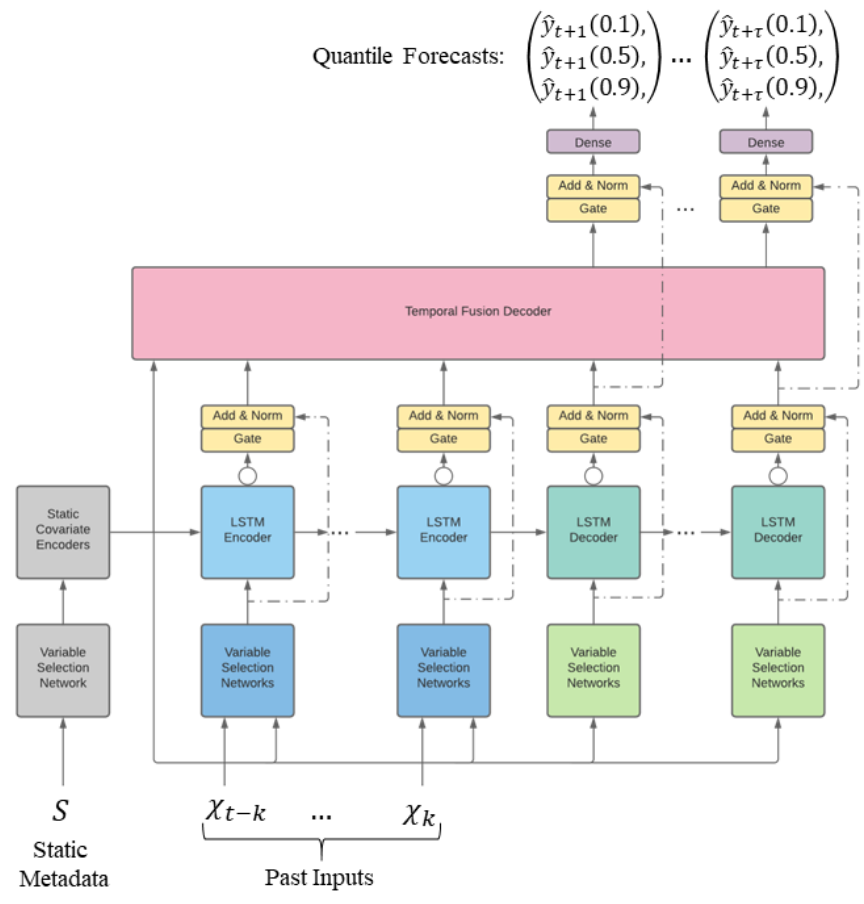
Figure 12. Temporal Fusion Transformers (TFT) architectural design. TFT inputs static attributes, time-varying historical inputs and time-varying a priori known future inputs. Variable filtering is used to allow a judicious selection of the most excellent features based on input. Gated Residual Network Blocks allow efficient information flow with skip and gating layer connections. Time-dependent processing is built on LSTMs for local processing and multi-head attention for the aggregation of information at any